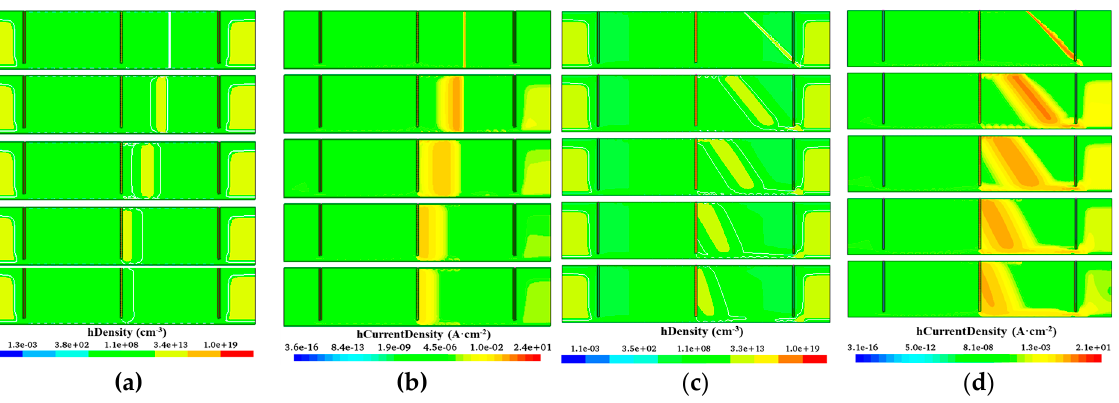
Figure 11. Hole density and hole current density at different times of a 3D large-area trench electrode silicon detector with floating ring ( a ) Hole density, α = 90°; ( b ) Hole current density, α = 90°; ( c ) Hole density, α = 45°; ( d ) Hole current density, α = 45°.